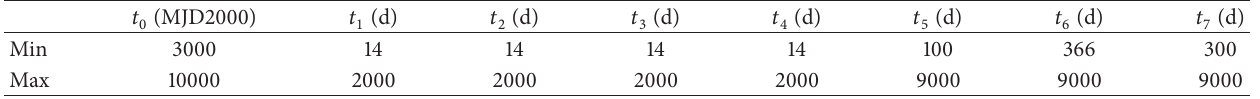
Table 3: Value range of each variable in GTOC1.